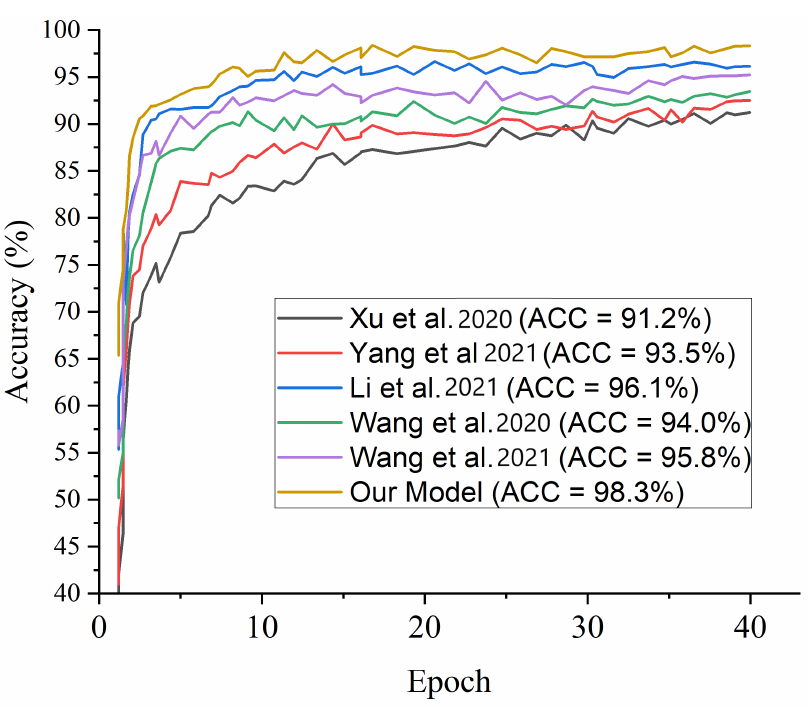
Figure 15. Accuracy performance for some selected state of the art models using the same